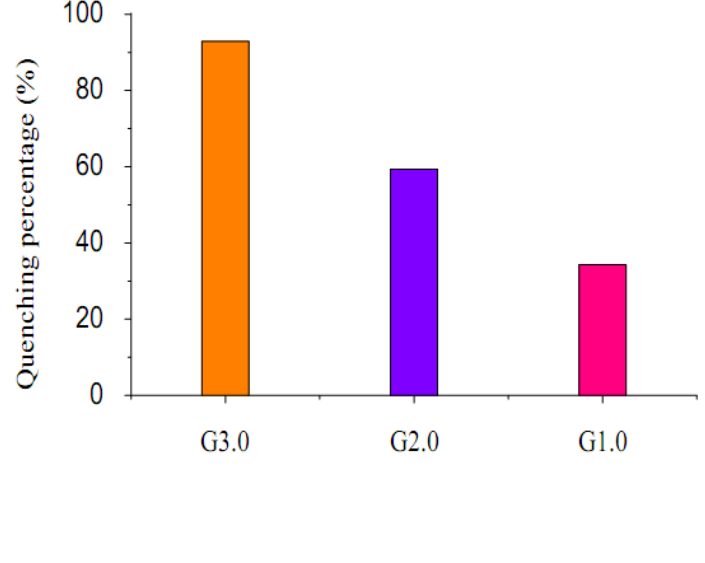
Figure 6. Fluorescence Quenching percentage [(I (5 × 10 -5 mol/L) upon the addition of 1.0 equiv Fe 3+ ion in water/methanol (1:1, v/v ). Excitation wavelength is 320 nm. Emission wavelength is 490